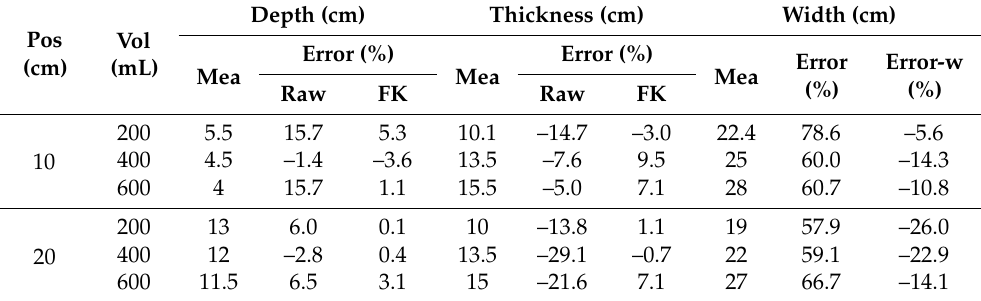
Table 7. GPR detection error of the moistube irrigation SWB at the longer scan line.